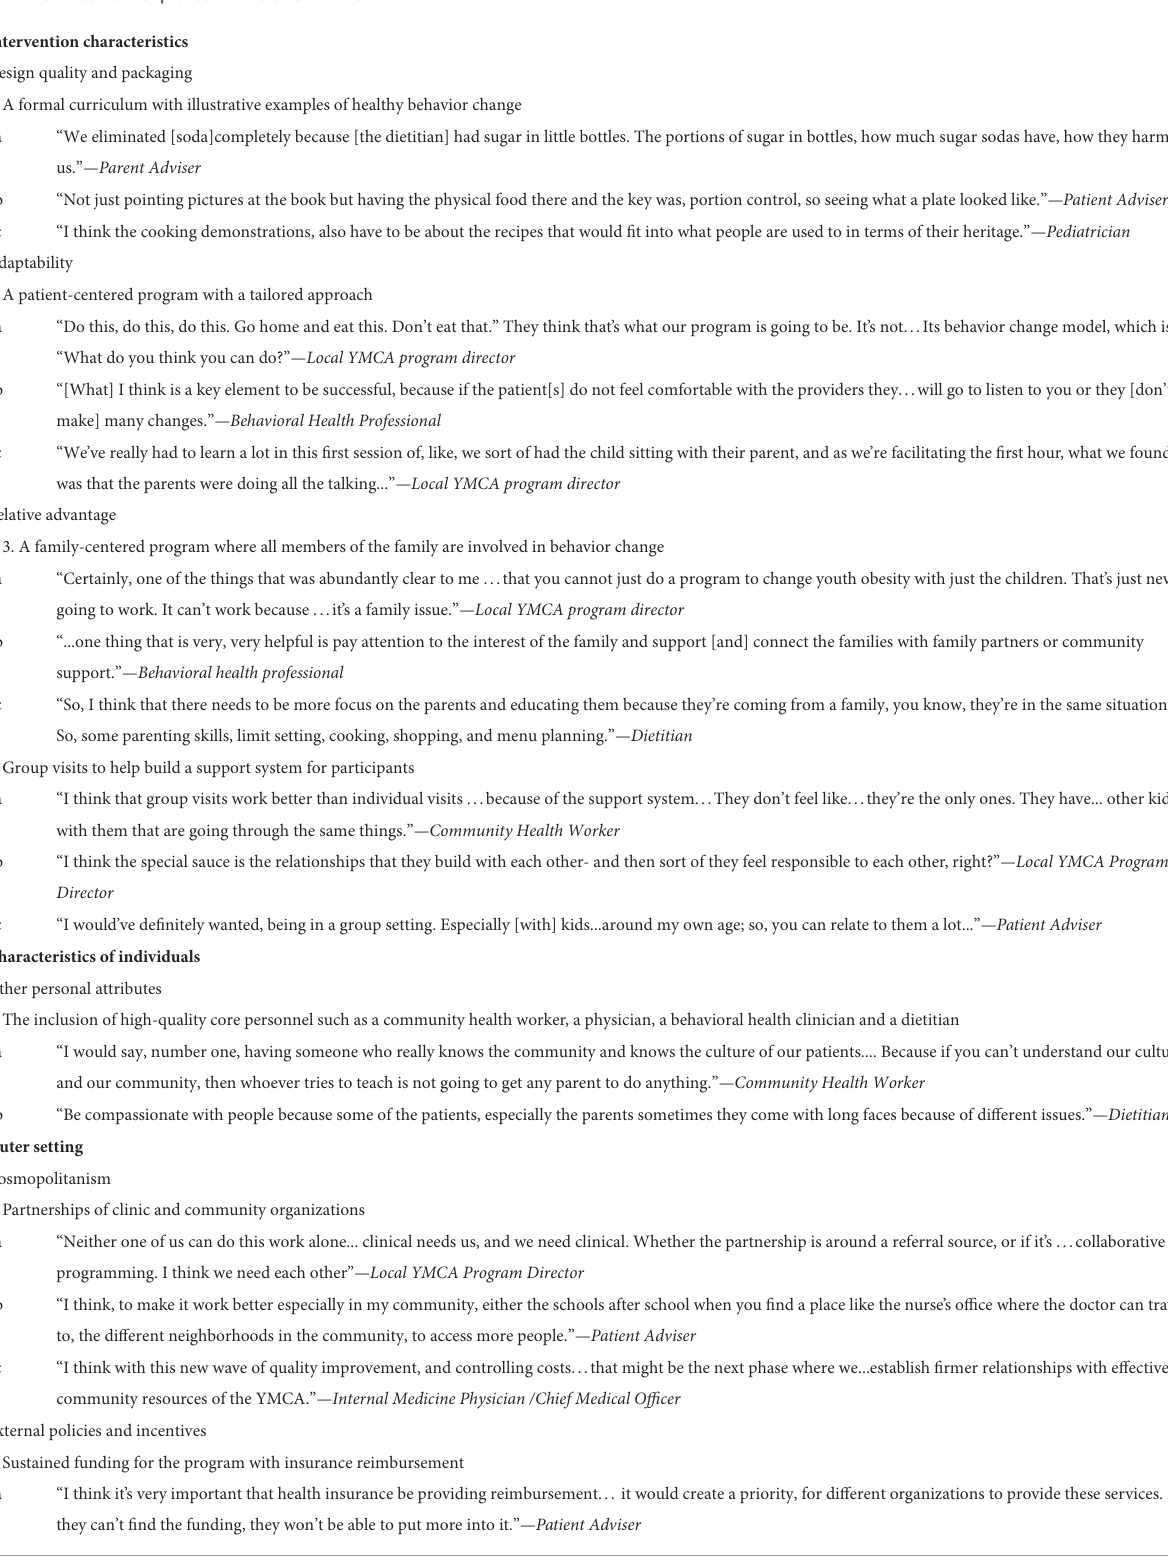
TABLE 3 Illustrative quotes from